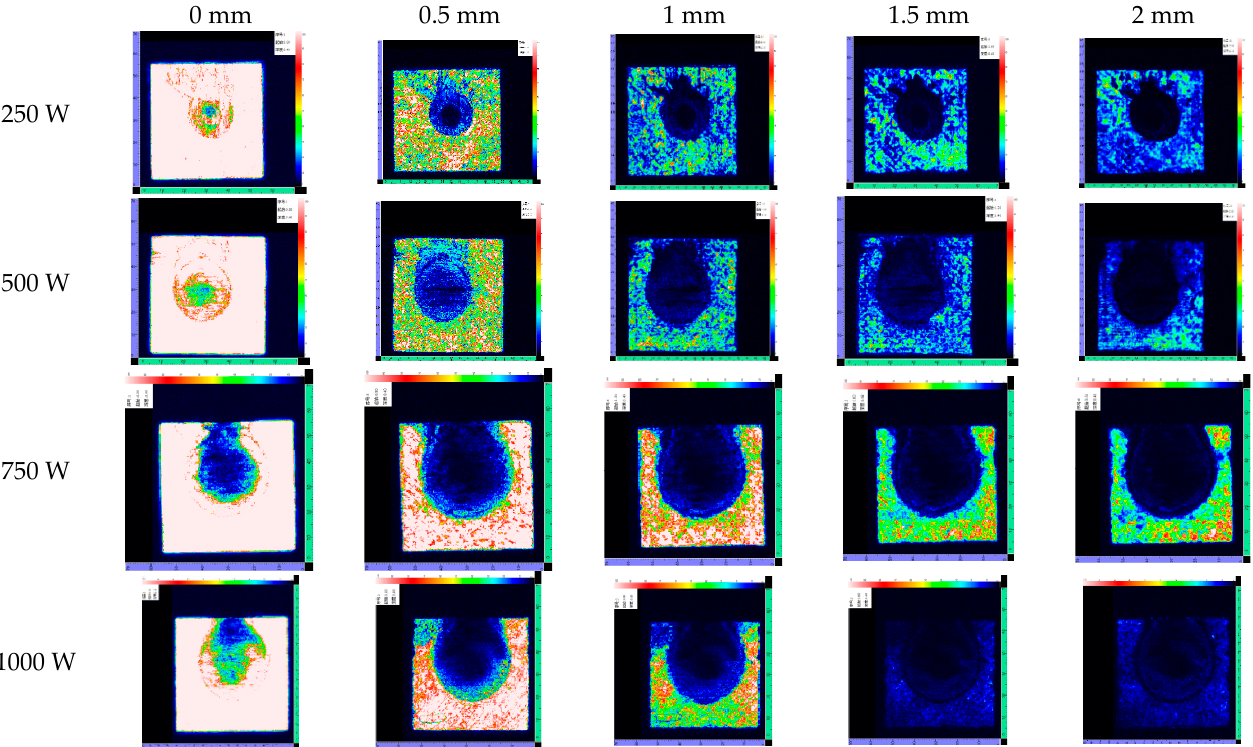
Figure 9. Time-of-flight images showing the distribution of delamination for CFRP laminates irradiated by different laser power.